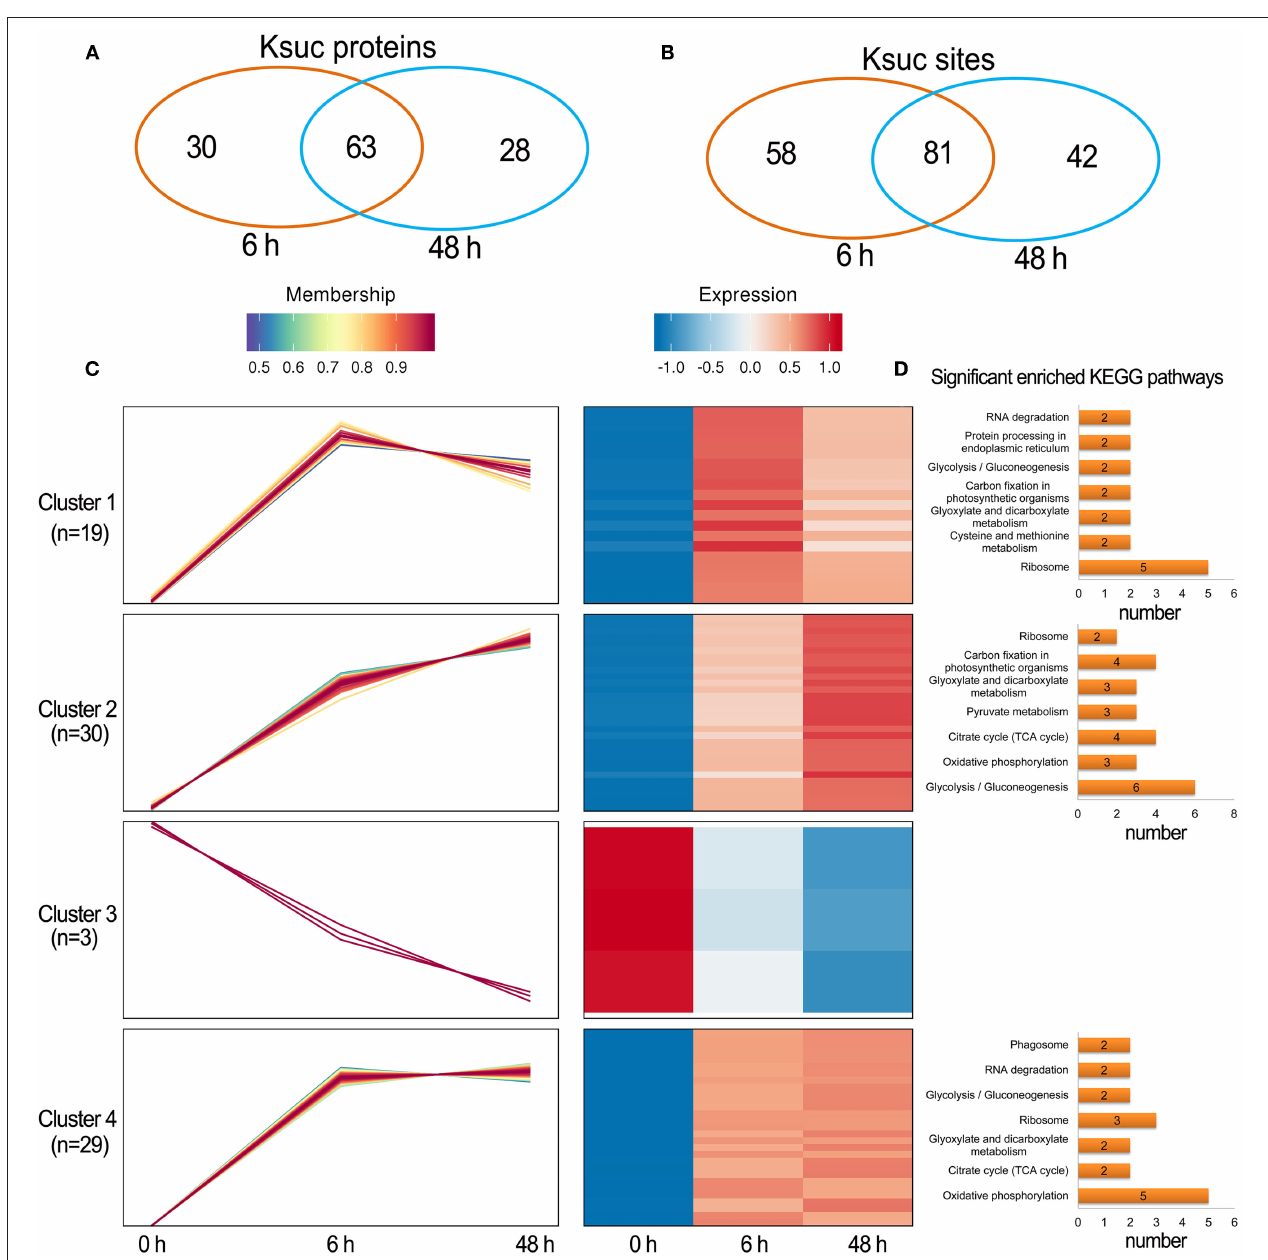
FIGURE 7 | Summary of differentially succinylated proteins in response to Pi recovery. (A,B) Venn diagram of difffrentially abundant succinylated proteins (sites) in response to Pi recovery; (C) functional clustering analyses (HCL) of the differentially succinylated sites based on the relative succinylation intensity, relative to the control. Cluster identification and number of profiles included in each cluster are indicated on the left. Detailed view of individual profiles is in Supplementary Table 6 ; (D) KEGG pathway enrichment analysis of DFASPs in each